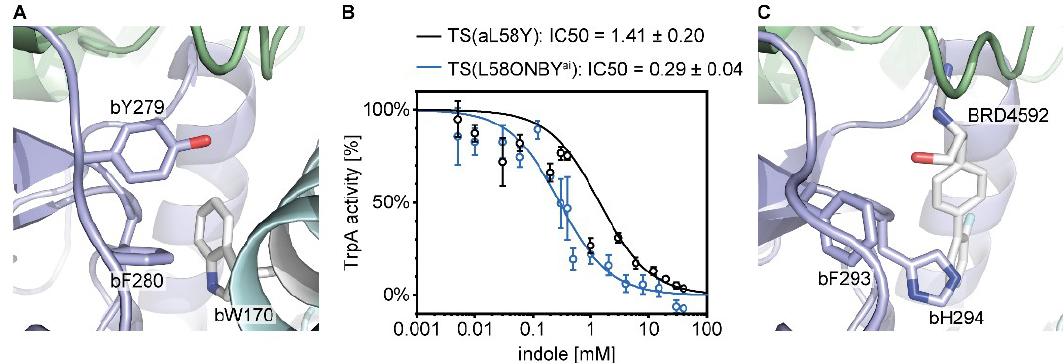
Figure 7. Blockade of the intermolecular indole channel by three different mechanisms. ( A ) The bC170 mutation to tryptophan (bW170) is located close to the two gating residues bY279 and bF280 (PDB ID 1fuy). ( B ) Product inhibition of TrpA in TS(aL58ONBY ai ) compared to TS(L58Y) by increasing indole concentrations. Reaction conditions: 50 mM Tris·HCl pH 7.8, 100 mM NaCl, 5 µM GAP dehydrogenase, 55 µM IGP (~K m ), 5 mM NAD + , 20 mM Na 2 HasO 4 , 40 µM PLP, 0–40 mM indole, and 1 µM TS (1:1 TrpA:TrpB). Data are shown ± SEM and were fitted with the dose-response equation (4). IC50 values are given ± SE. ( C ) TS inhibitor BRD4592 is bound in the intermolecular channel of M. tuberculosis mt TS close to the two gating residues bF293 (corresponds to bY179 in TS) and bH294 (corresponds to bF280 in TS) (PDB ID 5tci). TrpA: Green, TrpB: Blue, COMM: Cyan.